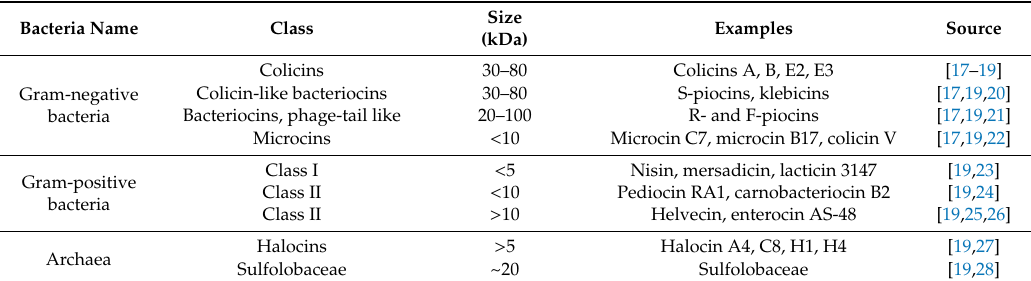
Table 1. Classification of